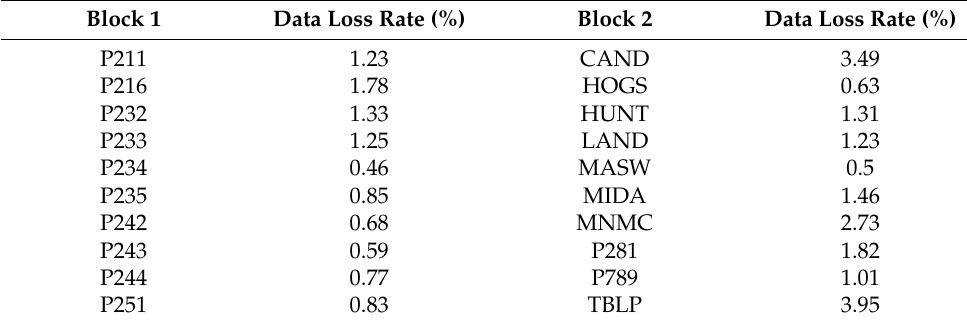
Figure 1. Distribution of International GNSS Service (IGS) reference stations. Table 1. Data loss rates for Blocks 1 and 2.